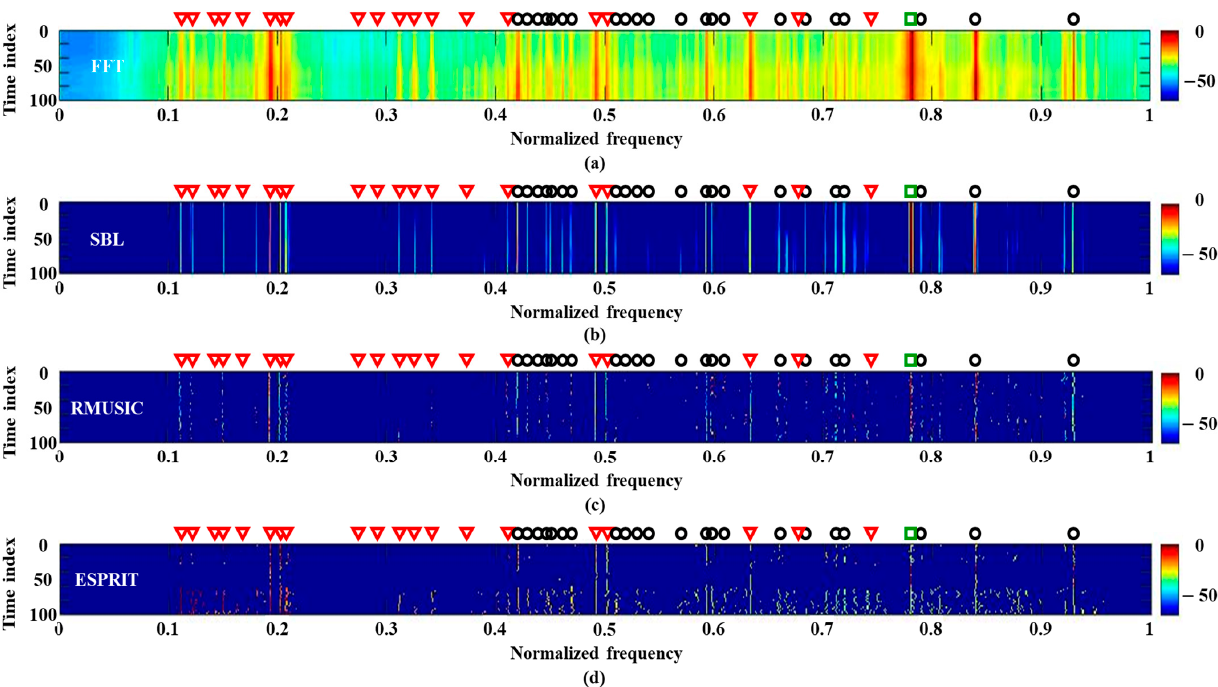
Figure 6. The frequency detection results using temporal multiple measurements, which are measured when the experi- mental ship is around the array: ( a ) FFT; ( b ) SBL; ( c ) RMUSIC; ( d ) ESPRIT.